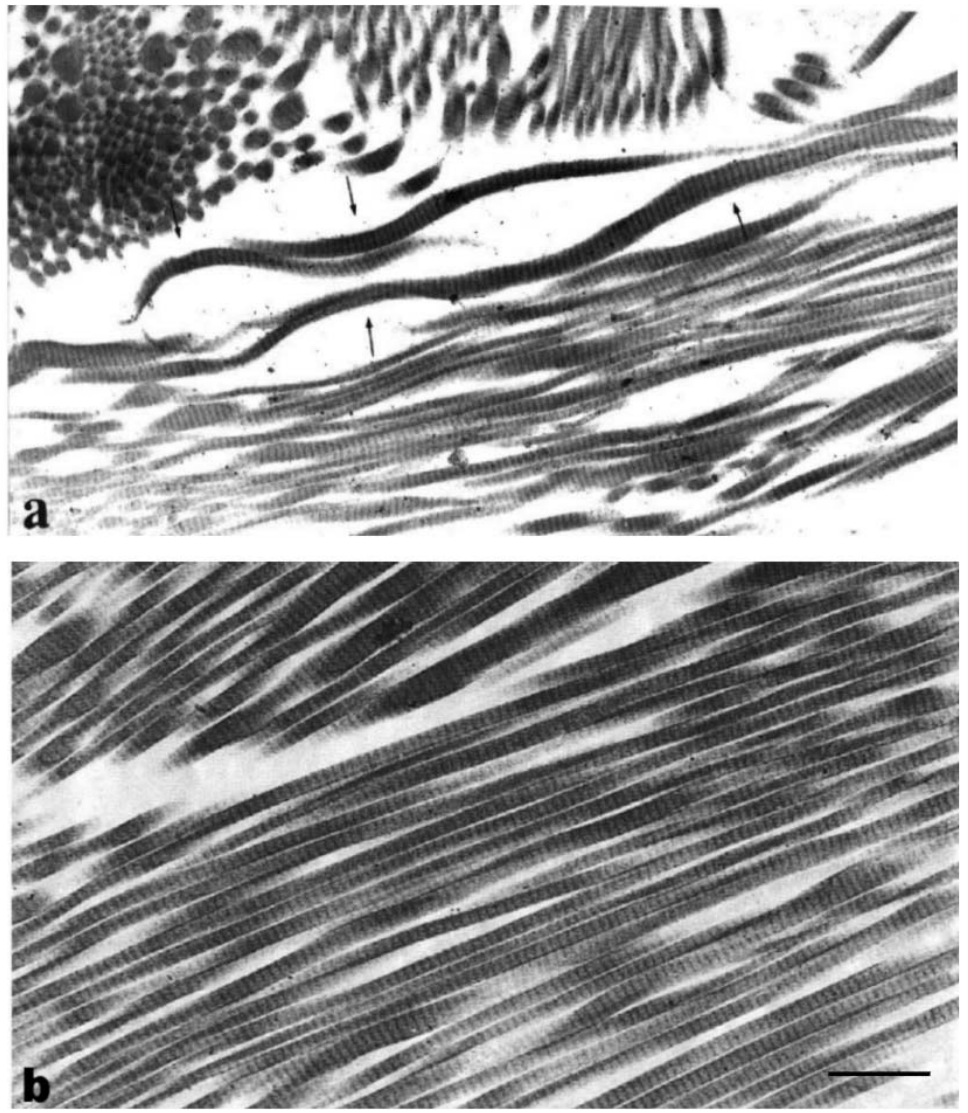
FIGURE 2. Twisted skin collagen fibrils from mice treated with 6 meq Li/kg for 30 consecutive days (a). Some abnormally thick fibrils are present (indicated with arrows), which are due to spiraled aggregates of smaller fibrils. Animals were sacrificed 1 month after the last lithium injection. (b) Normal fibrils for comparison. Bar = 0.5 µm.